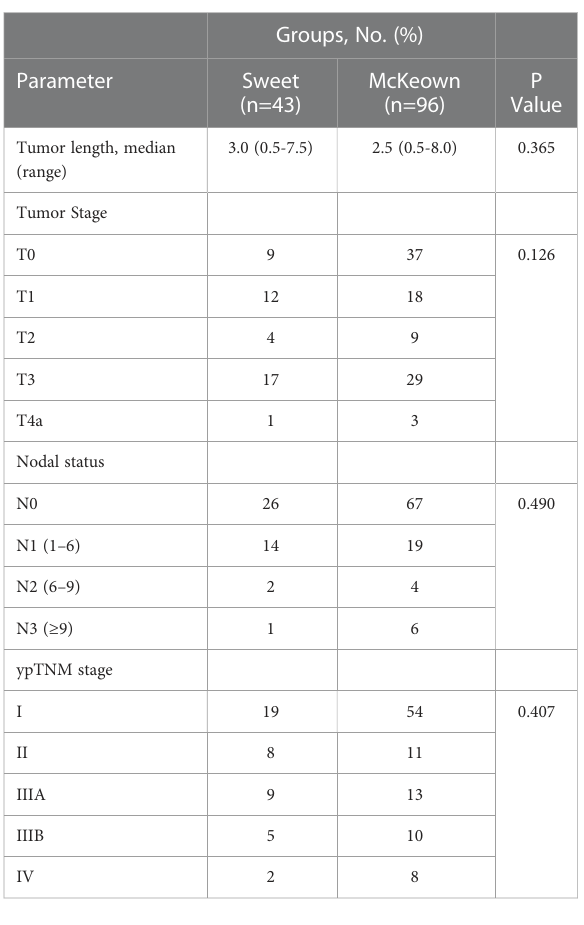
TABLE 2 Histological Parameters.